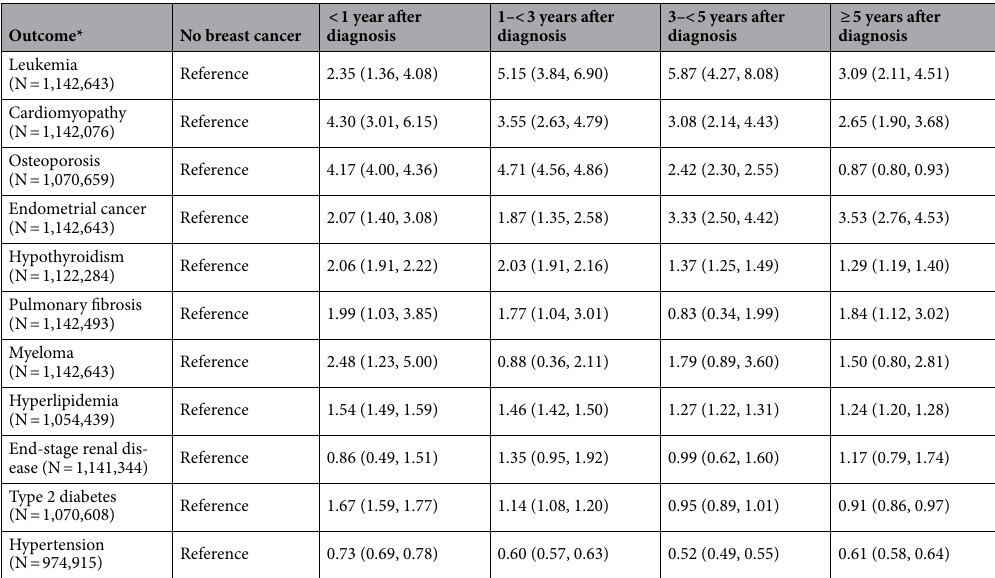
Table 3. Hazard ratios (95% confidence intervals) for incident outcomes after incident breast cancer by time after breast cancer diagnosis. Each outcome was analyzed separately. Each analysis was performed among participants free of the outcome disease at baseline and adjusted for body mass index category (underweight, normal, overweight, obese, and unknown), alcohol intake (none, moderate, heavy, and unknown), physical activity (none, 1–2 times per week, ≥ 3 times per week, and unknown), smoking status (never smoker, ever smoker, and unknown), income percentile (Medical Aid, ≤ 30th, 31st–70th, > 70th percentile), as well as for the baseline presence of comorbid conditions other than the corresponding